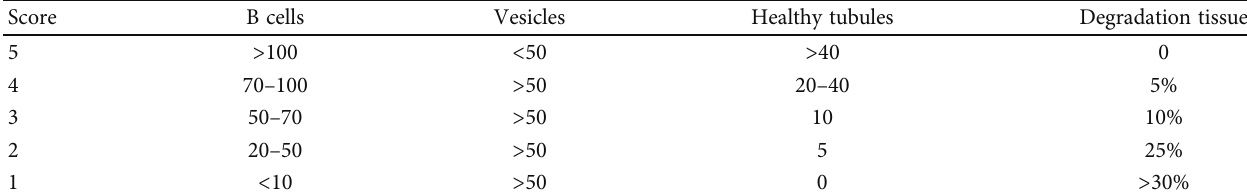
Table 3: Categorization range created to measure the hepatopancreas status of P. vannamei postlarval stage 12. Score B cells